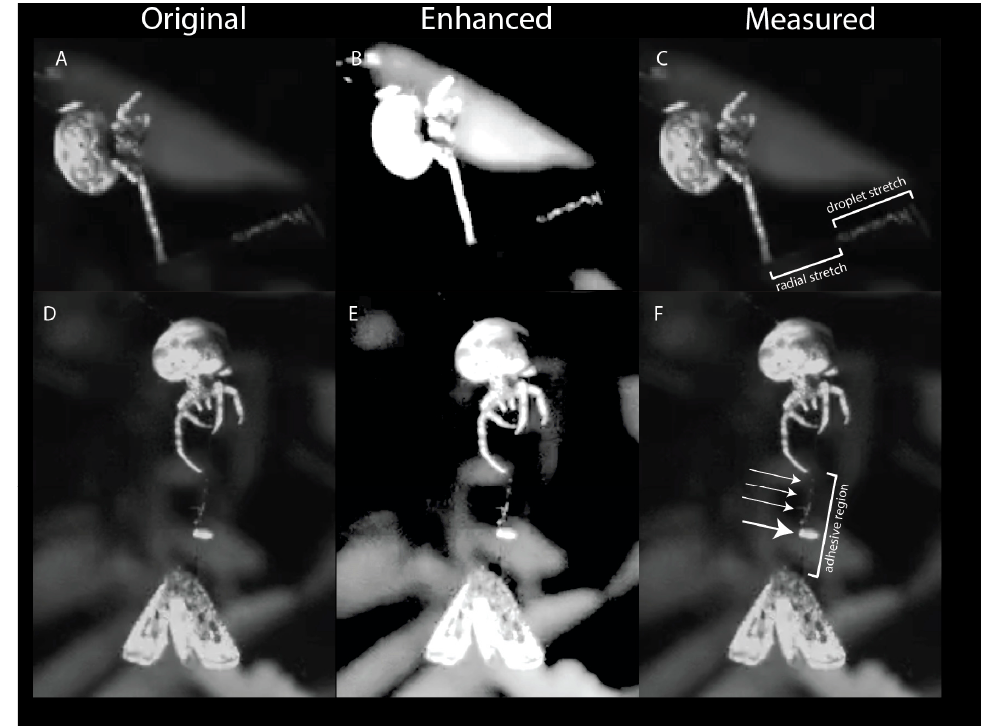
Figure 4. Behavior of the bolas during capture. The spider flicks its bolas towards the moth (off screen to the right). In the original image ( A ), a still from the high-speed video, the bolas can be seen as it stretches. Enhancement of the image ( B ), by increasing the exposure and contrast, more clearly shows the structure of the droplet as it stretches; the liquid phase of the droplet (white) remains associated with the thread of the windlass as it unfurls. The droplet continues to be tethered to the spider by the radial thread, which also stretches ( C ). The spider reels in the moth ( D , E ). In the original image ( D ) the spider is hauling in the radial thread as the moth dangles from the stretched droplet. In the enhanced image ( E ), the scales attached to the droplet can be seen as a large clump (elliptical white structure) and smaller clumps (smaller white regions) on the windlass. The stretched droplet forms an elongated adhesive region ( F ), with a large clump (large arrow) and small clumps (small arrows) that were cre- ated during the initial deposition of the glue droplet onto the moth.